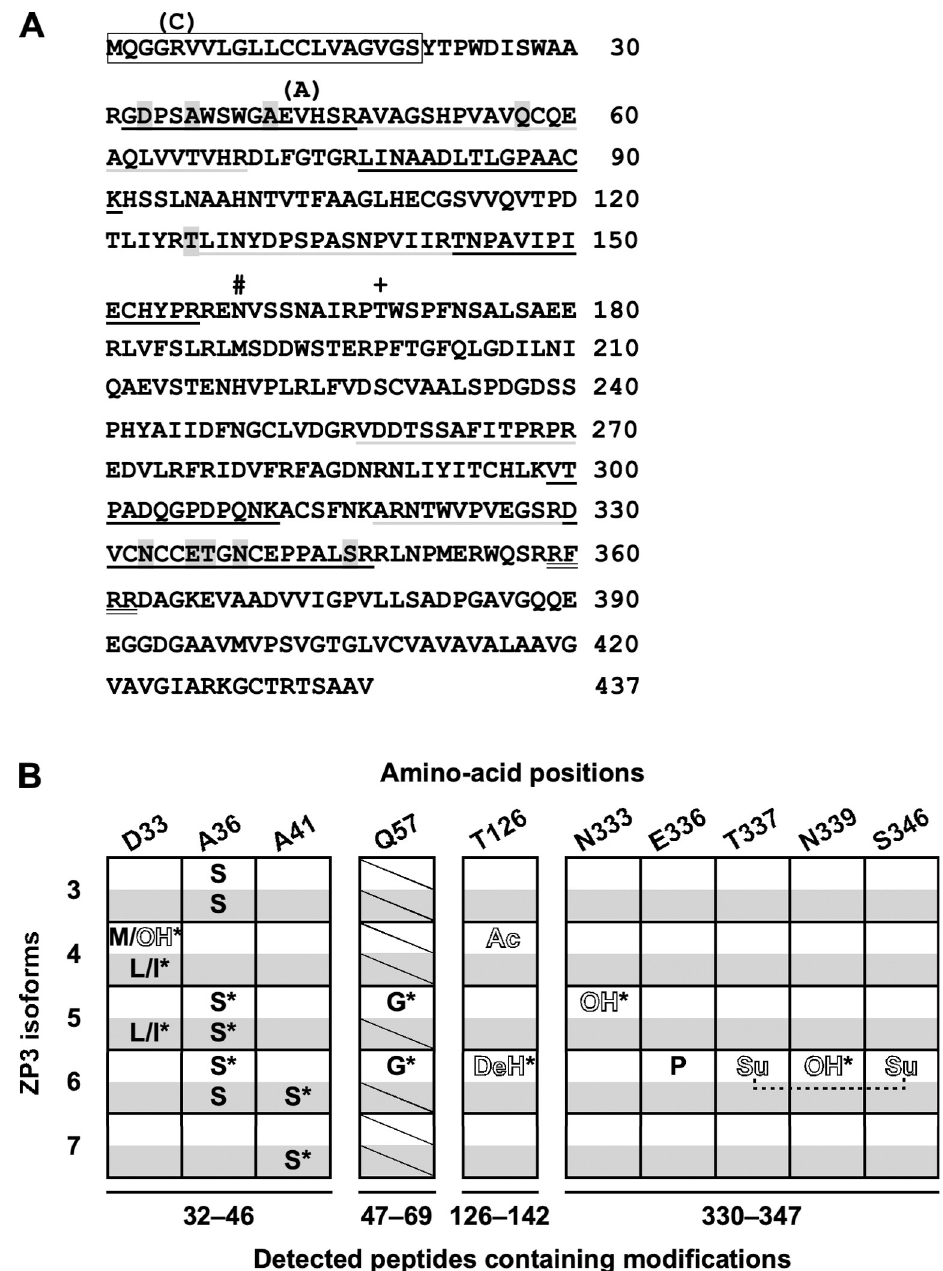
Fig 4. Characteristic post-translational modifications and amino-acid substitutions on the ZP3 isoforms. (A) Major ZP3 isoforms 3 to 7 were separated by 2D-PAGE of the IPVLs that were collected from the yellow follicle F1 of both the commercial White-Leghorn and WL-G hens, and analyzed by tandem mass spectrometry (MS/MS) analyses. Amino-acid sequence of chicken ZP3 is shown based on GenPept accession no. NP_989720.3, although its methionine (M) 10 is interpreted as the N-terminal methionine (M) according to GenPept accession no. BAA13760.3. The putative signal peptide and a potential consensus sequence for furin cleavage are indicated by a rectangle and a double underline , respectively, and the potential N -glycosylation site and the previously identified O -glycosylation site [31] are indicated by # and + symbols , respectively. The alternate black and gray underlines indicate the peptides detected by MS/MS analyses, and the amino-acid residues containing the identified modifications are shadowed . The C5 and A43 mutants derived from the heterozygous allele of WL-G chicken are shown in parentheses . ( B ) Amino-acid positions containing post-translational modifications ( outlined letters ) and polymorphic amino-acid substitutions ( regular letters ) that are identified at significance levels of P < 0.05 ( � : P < 0.01) are summarized for ZP3 isoforms 3 to 7 of both the commercial White-Leghorn ( white boxes ) and the WL-G ( shadowed boxes ) hens. Original amino-acid positions